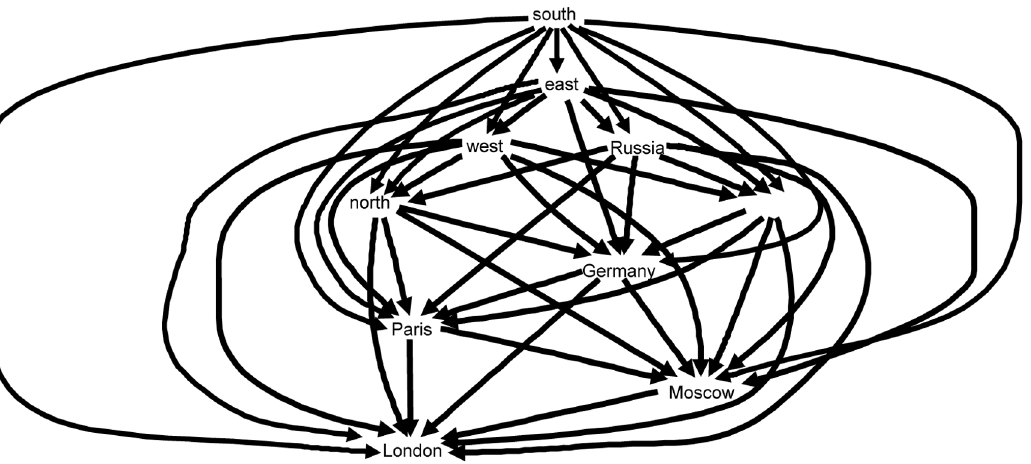
Figure 10. Ordinal relation of similarity differences represented as a directed acyclic graph CG B London for London relative to the set of words { London,Moscow,Paris,north,south,east,west,Germany,Poland,Russia }, derived from the probability density estimates for the brain data in Figure 1.